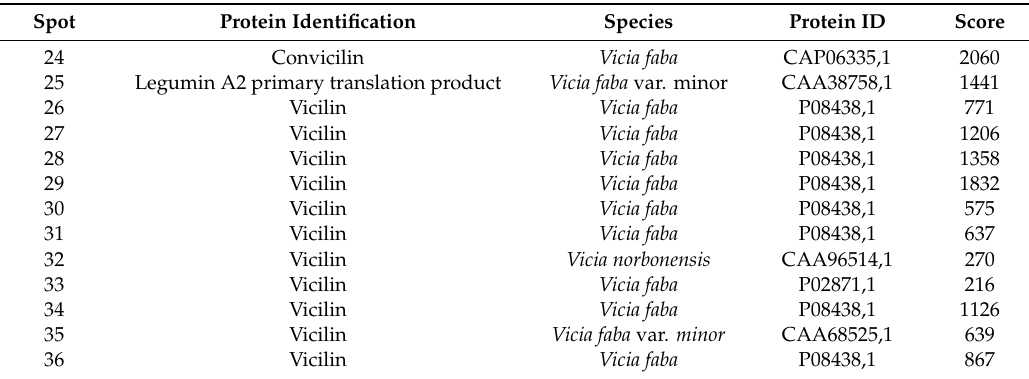
Table 5. Vicilin identification by LC-MS-MS /